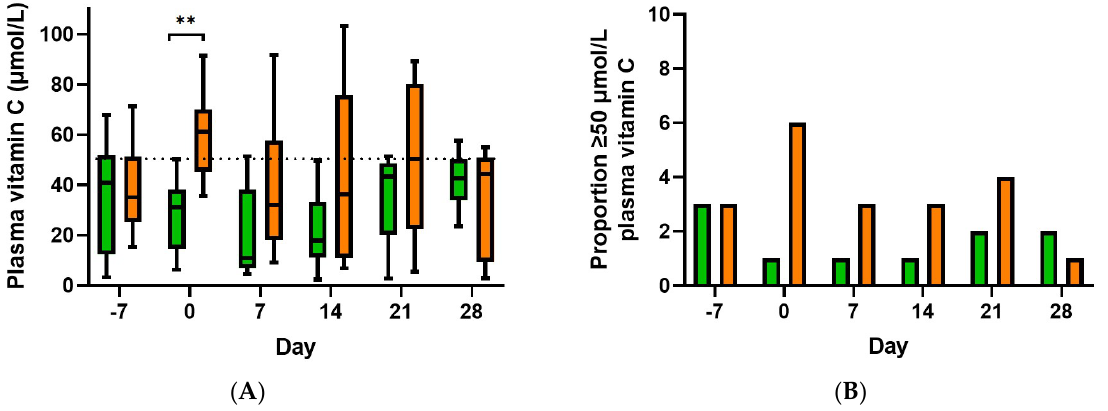
Figure 2. Effect of oral vitamin C supplementation on plasma vitamin C status of participants ( A ) and proportion with plasma vitamin C concentrations ≥ 50 µmol/L ( B ). Placebo group, green bars; vitamin C group, orange bars. Box plots represent median and 25th and 75th percentiles with minimum and maximum whiskers. Dashed line indicates 50 µmol/L vitamin C. Mixed-effects analysis indicated a significant difference between the two groups; ** p = 0.002 by post hoc analysis.